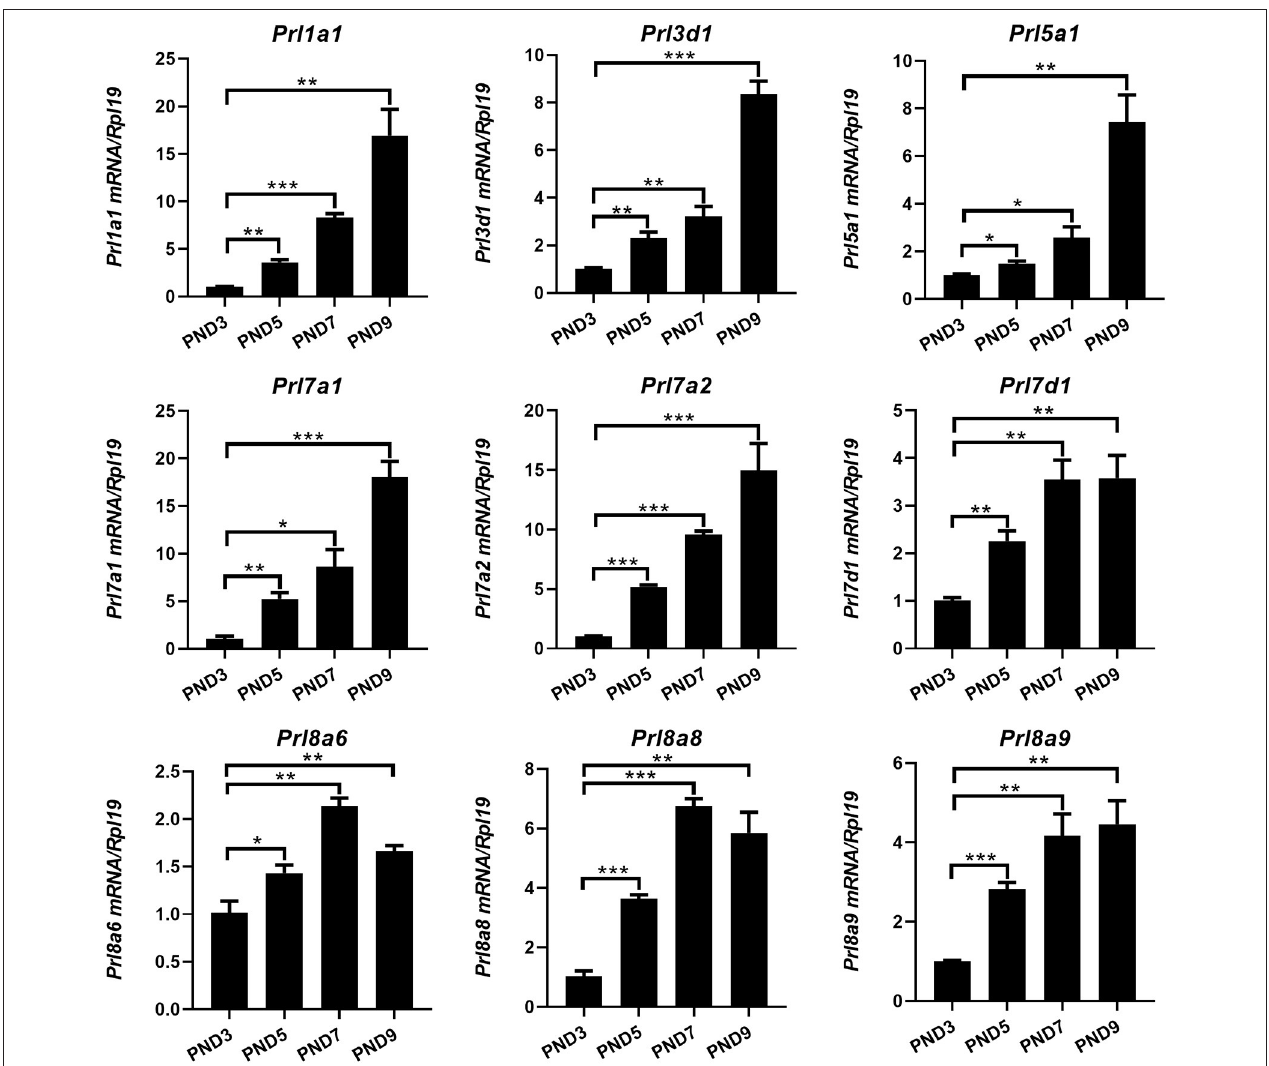
FIGURE 2 | Quantitative Real-time-PCR analysis of Prl1a1 , Prl3d1 , Prl5a1 , Prl7a1 , Prl7a2 , Prl7d1 , Prl8a6 , Prl8a8, and Prl8a9 mRNA levels in the endometrium of neonatal mice during the early postpartum period. The mRNA expression level of 9 prolactin family members during the development of the uterine endometrium from PND3 to PND9.Results are means ± SEM ( n = 5). Bars with different superscripts are significantly different ( P <